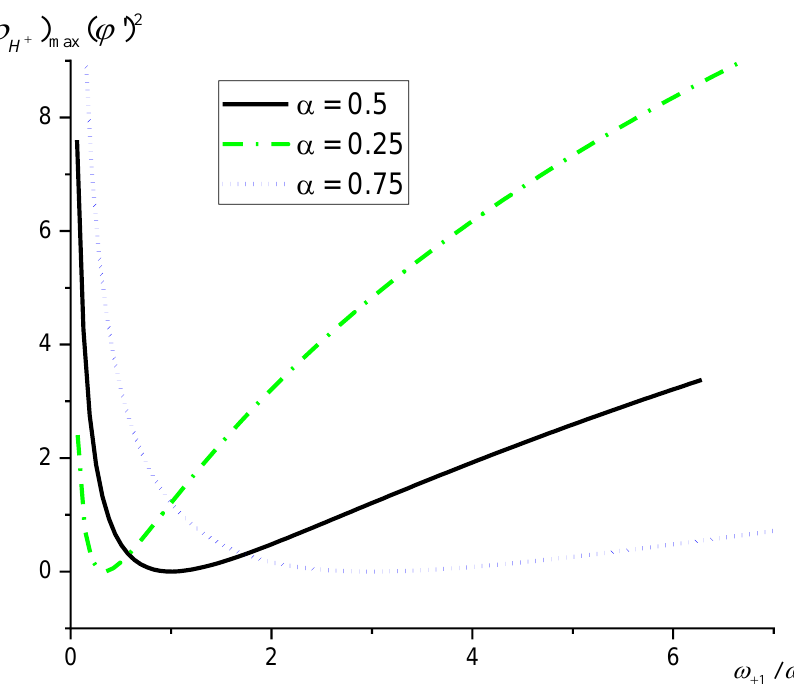
( ϕ (cid:48) ) 2 as a function of the ratio of the frequencies of the first and Figure 1. Dependence of ( ρ H + ) max second steps in the forward direction according to Equation 2 ()( ' )   Figure 1. Dependence of as a function of the ratio of the frequencies of the first m a x + H and second steps in the forward direction according to Equation (26).